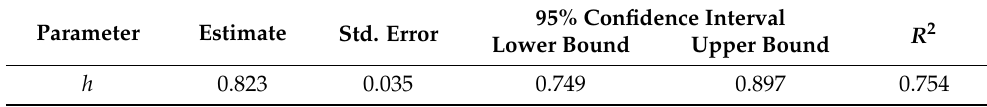
Table 7. Results obtained in the numerical